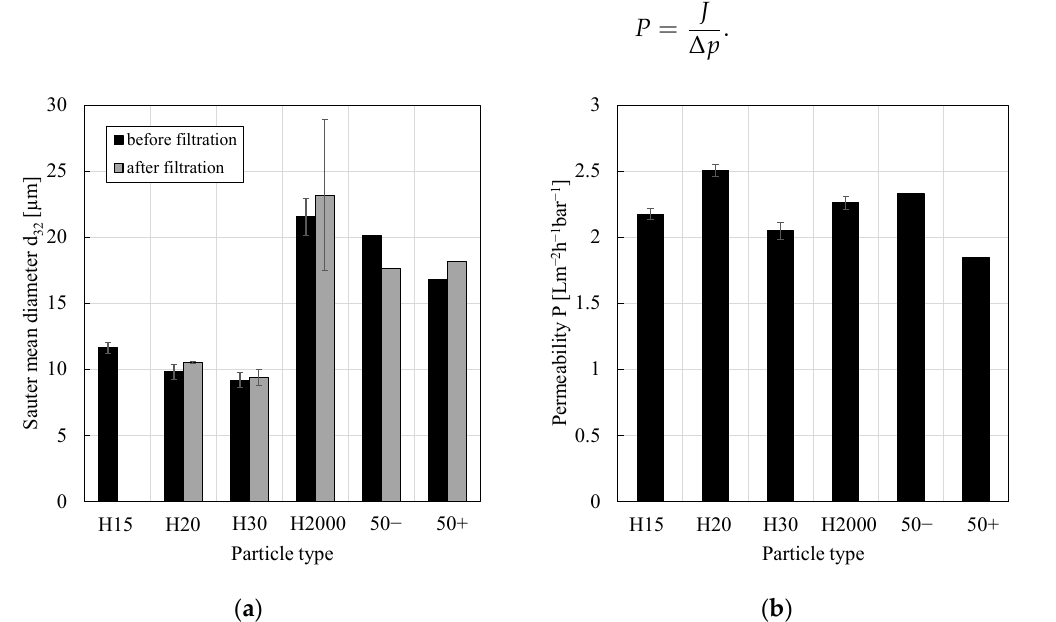
Figure 1. ( a ) Sauter mean diameter and ( b ) permeability of w/o PEs stabilized by 0.5 wt.% of different silica particles. The PEs stabilized by particle types 50 − and 50+ were investigated once and used for hydroformylation reactions (and subsequent concentration filtration experiments). All other emulsions were prepared without the catalyst-ligand complex and investigated at least in duplicate pressure stepping experiments. Mean values are shown and error bars represent the standard deviation. Drop size distributions for particle types H15, H20, H30 and H2000 were already published in [14] and Sauter mean diameters for particle types 50 − and 50+ were published in [18].